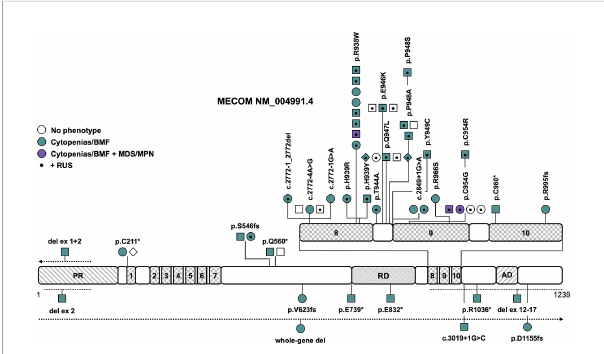
FIGURE 2 Schematic of the MECOM transcript (NM_004991.4) and its protein domains with the location of all reported germline variants. Checkered domains with the numbers 1 to 10 stand for zinc fi ngers 1 to 10. Circles represent females, squares represent males and diamonds represent unknown gender. Symbols on the same horizontal level are individuals from the same family. The color fi ll depicts different phenotypes, no color fi ll indicates healthy individuals carrying a causative variant. A dot in the middle of the symbol designates the presence of RUS in these individuals. The dotted lines show the location of the described copy number variants, the arrow denotes that the copy number variant extends in this direction. AD, acidic domain; BMF, bone marrow failure; MDS, myelodysplastic syndrome; MPN, myeloproliferative neoplasm; PR, PRDF1-RIZ domain; RD, repression domain; RUS, radioulnar